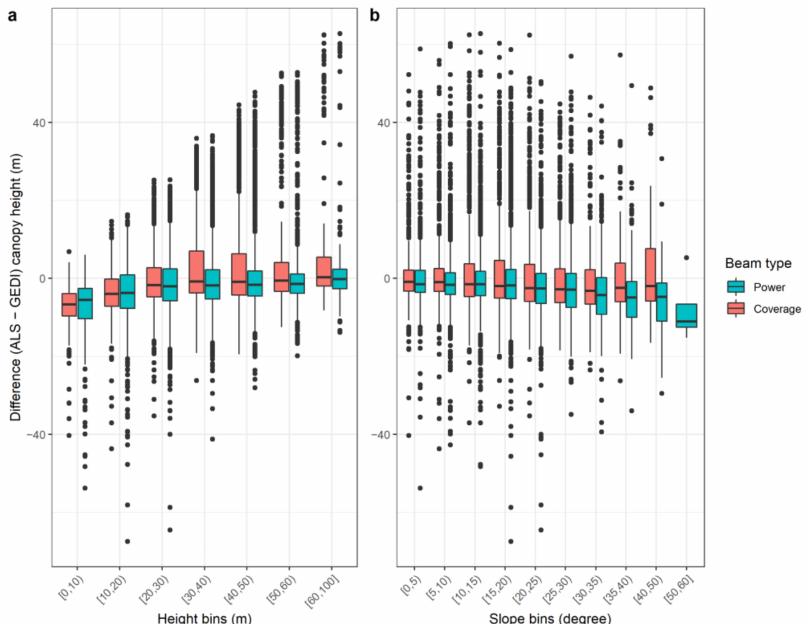
Figure 6. Boxplot of differences in canopy heights between ALS and GEDI, i.e., (ALS 95 , GEDI 95 ) for in- dividual footprints (11,832) in different canopy height bins ( a ) and in different slope bins ( b ). Canopy height differences are shown for footprints from the two types of beams (power and coverage).